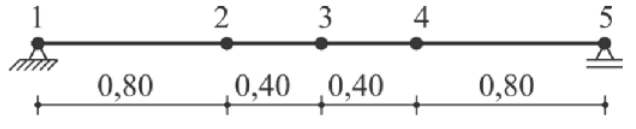
Finite element mesh simple supported RC beam. Dimensions in